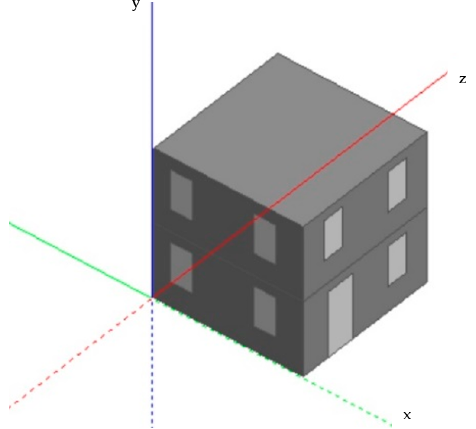
Figure 4. 3D view of the case study used for simulation.